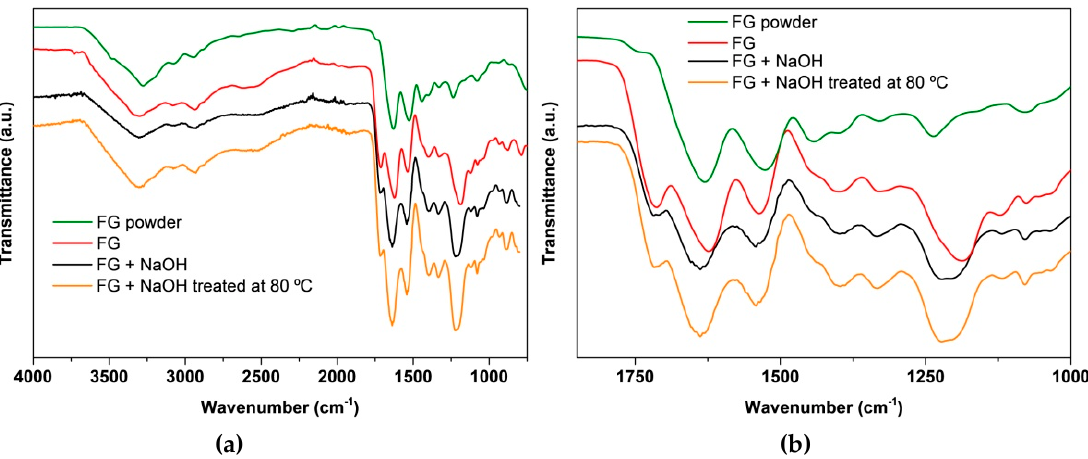
Figure4. ATR-FTIRspectraofFGpowder, FG,FG + NaOH,andthermallytreatedFG + NaOHelectrospun Figure 4. ATR-FTIR spectra of FG powder, FG, FG+NaOH, and thermally treated FG+NaOH mats ( a ) from 4000 to 800 cm − 1 and ( b ) from 1850 to 1000 cm − 1 electrospun mats ( a ) from 4000 to 800 cm − 1 and ( b ) from 1850 to 1000 cm − 1 .